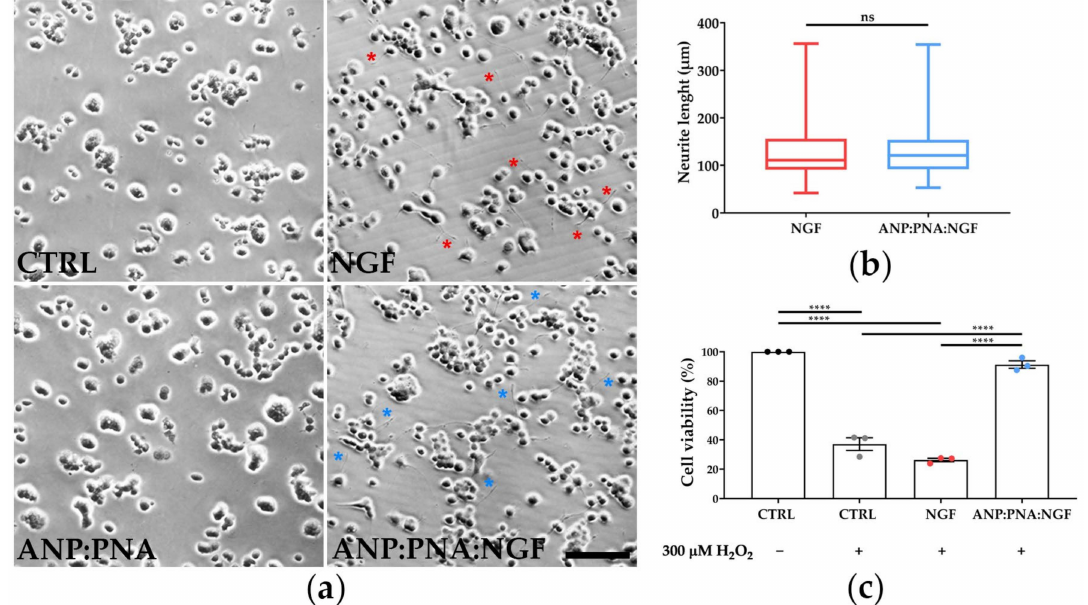
Figure 4. NGF exerts its biological activity upon nanoformulation. ( a ) Representative images of PC12 cells incubated for 4 days with 100 ng/mL of free NGF or with the same concentration of NGF bound to PNA-conjugated polyacrylamide nanoparticles (ANP:PNA:NGF). As control, PC12 cells were incubated with PNA-conjugated nanoparticles (ANP:PNA) or DPBS. Red and blue asterisks indicate the presence of neurites in cells exposed to NGF and ANP:PNA:NGF, respectively. Scale bar: 300 µ m. ( b ) Quantitative evaluation of neurite length in PC12 cells incubated with NGF or ANP:PNA:NGF. n = 180 neurites from 3 biological replicates, t-test for unpaired data followed by Kolmogorov– Smirnov test. ( c ) Protective effect of NGF-conjugated polyacrylamide nanoparticles against oxidative stress. ARPE-19 cells were cotreated with 100 ng/mL of free NGF (NGF) or nanoformulated NGF (ANP:PNA:NGF) and 300 µ M of H 2 O 2 for 24 h. MTT assay was performed to evaluate cell